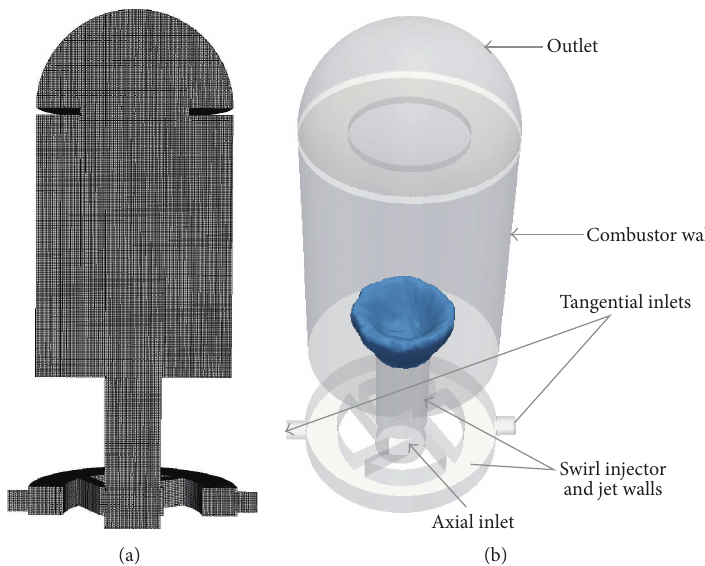
Figure 1: (a) Mesh and (b) numerical domain and the mean flame location for the benchmark